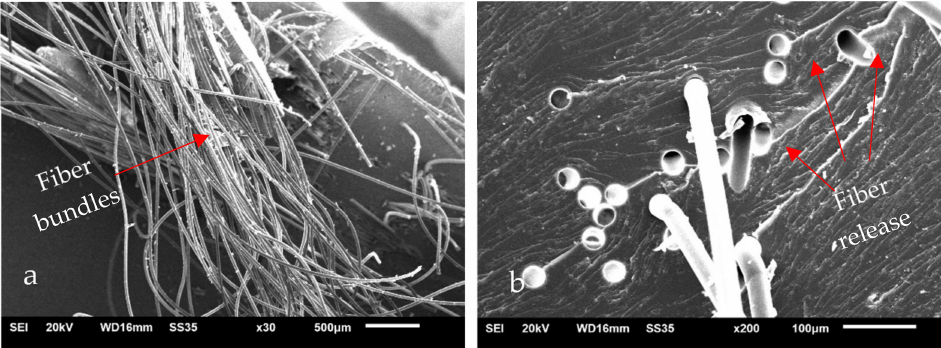
Figure 7. Scanning Electron Microscopy of PET 5% composite fractured surfaces. ( a ) PET fiber bundle; ( b ) PET fiber